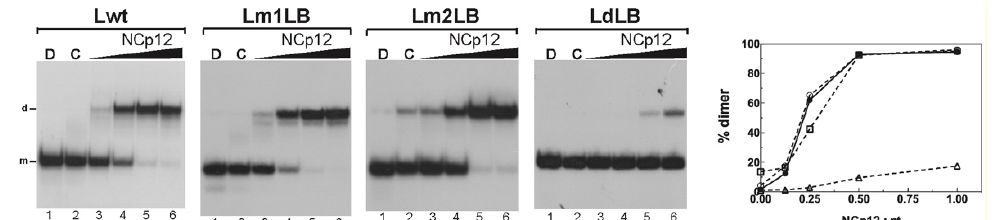
Figure 4. Dimerization of L RNAs harboring mutations in loop B. The 5 ′ -end-labeled L RNAs in the absence (lanes C) or the presence of NCp12 (lanes 3–6) were incubated at 37 °C as described in Materials and Methods. After phenol–chloroform extraction, the samples were analyzed by electrophoresis on 12% polyacrylamide gels at 25 °C in the TBE buffer. Heat-denatured L RNAs (lanes D) were used to identify the bands corresponding to monomeric L RNAs. Lanes 3–6, protein to nucleotide molar ratios were 1:8, 1:4, 1:2, and 1:1. The monomeric and dimeric forms of L RNAs are indicated by m and d, respectively. The graph was derived from the gels shown in this figure. Filled circles, Lwt RNA; open circles, Lm1LB RNA; open squares, Lm2LB RNA; open triangles, LdLB RNA.